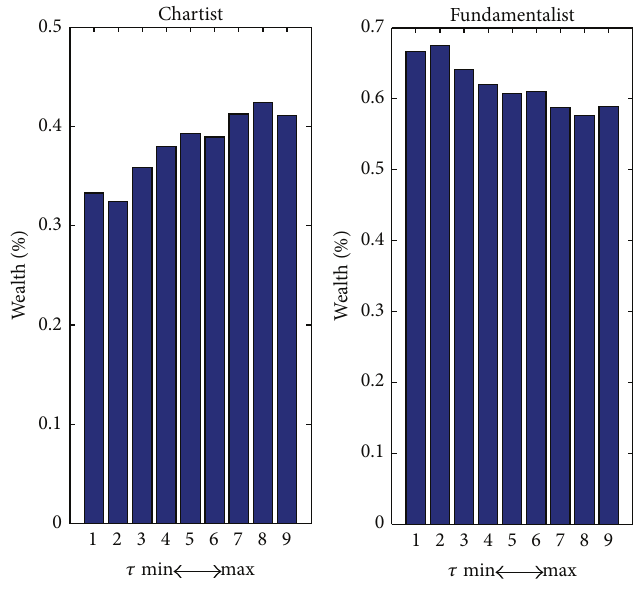
Figure 10: Wealth Shares (𝑑 𝑓 ∈ (0.8, 0.9))